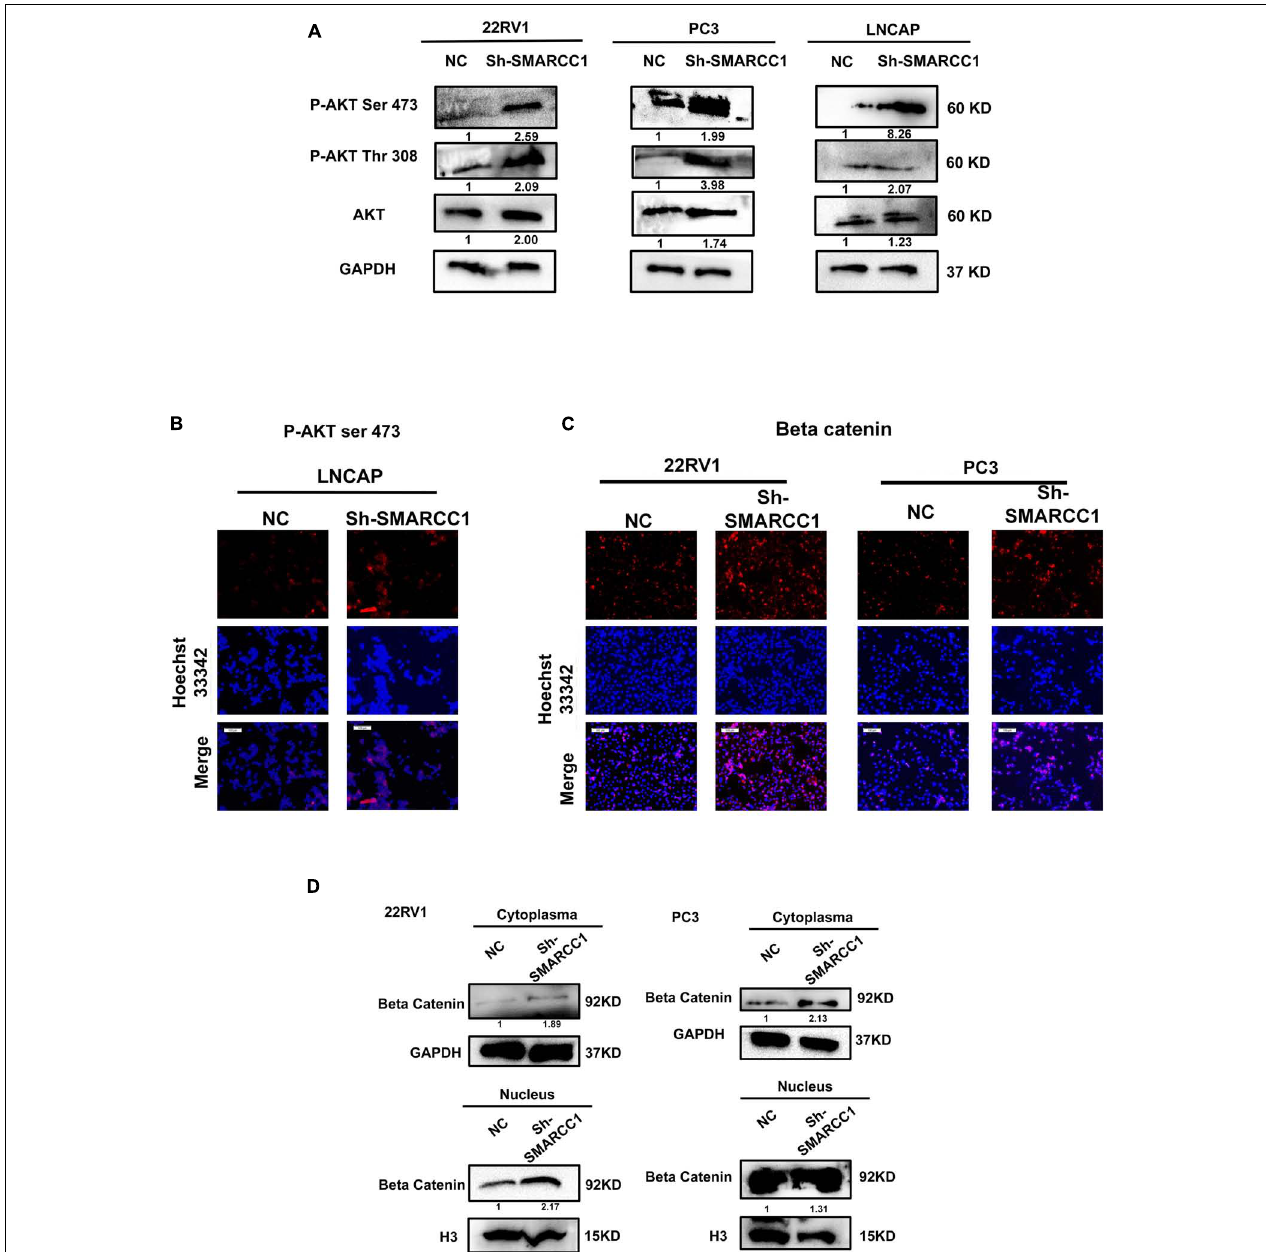
FIGURE 5 | SMARCC1 knockdown activated the PI3K/AKT pathway in PCa cell lines. (A) Immunoblots showing the expression levels of phosphorylated PI3K/AKT mediators. The gray density values are indicated under the corresponding bands. (B) Representative immunofluorescence images showing the in situ expression of p-AKT ser − 473 in the LNCAP cell line (scale bar, 100 µ m). (C) Representative immunofluorescence images showing the expression of β -catenin in the cytoplasm and nucleus of 22RV1 and PC3 cell lines (scale bar, 100 µ m). (D) Immunoblots showing the expression levels of β -catenin in the cytoplasmic and nuclear fractions. The gray density values are indicated under the corresponding